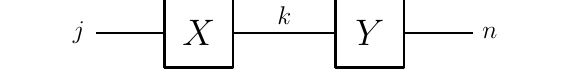
Figure 23 . A two-tensor network corresponding to a pure state.